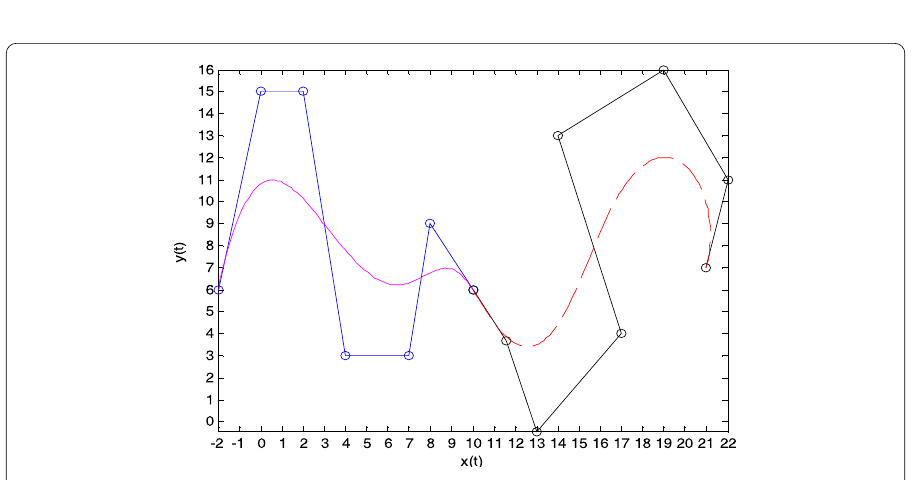
Figure 5 Example of G 2 smooth